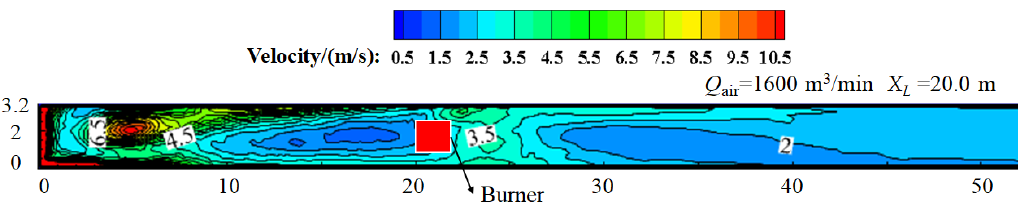
Figure 11. The flow field distribution at the height Z = 1.6 m. ( Q air = 1600 m 3 /min, X L = 20.0 m).